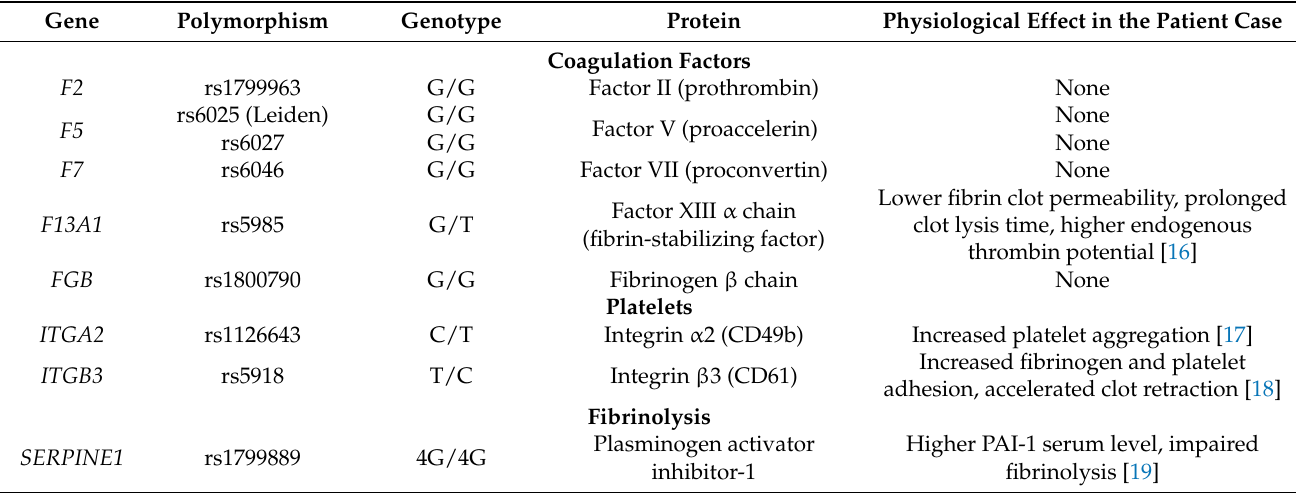
Table 3. Genetic testing for inherited